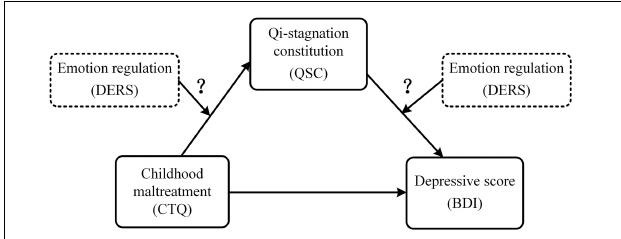
FIGURE 1 | The conceptual framework of the moderated mediation model. CTQ, total score of the Childhood Trauma Questionnaire-Short Form (CTQ-SF); QSC, conversion score of the Qi-Stagnation Constitution Scale; DERS, total score of the Difficulties in Emotion Regulation Scale; BDI, depressive sore using Beck Depression